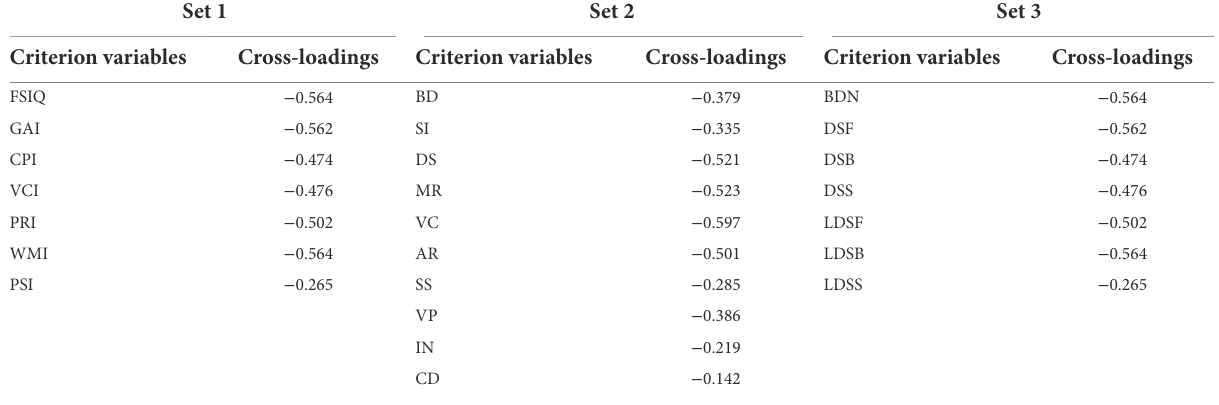
TABLE 6 Cross-loadings of the first redundancy